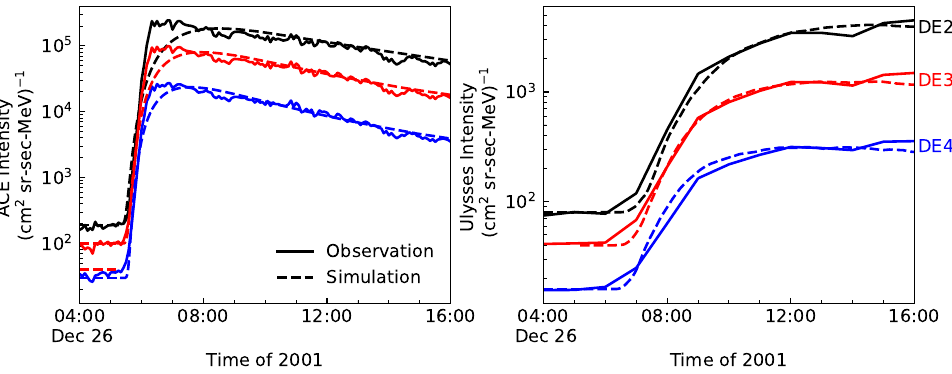
Figure 10. Electrons fluxes of the observations and simulations in DE2–DE4 during the 26 December 2001 SEP